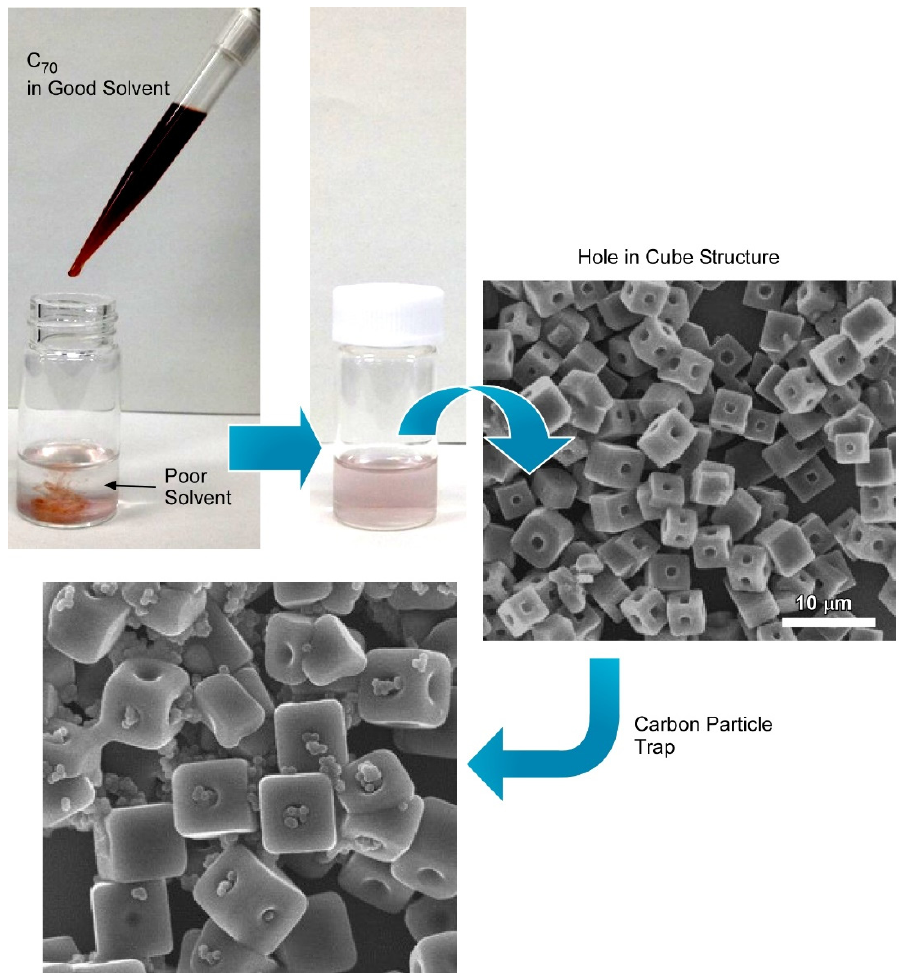
Figure 6. Fabrication of C 70 cube with open hole on each face of the cube (hole-in-cube structure) through controlled self-assembly at the liquid–liquid interface and trapping capability for carbon particles. Reprinted with permission from Reference [142]. Copyright 2017 American Chemical Society.